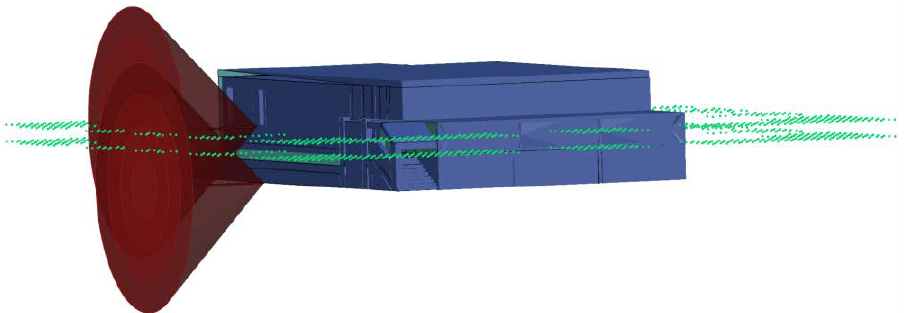
Figure 9. The candidate viewpoints and the cone of two points of the initial mesh for façade pointing. For better visualization, only the cone with the two initial points is